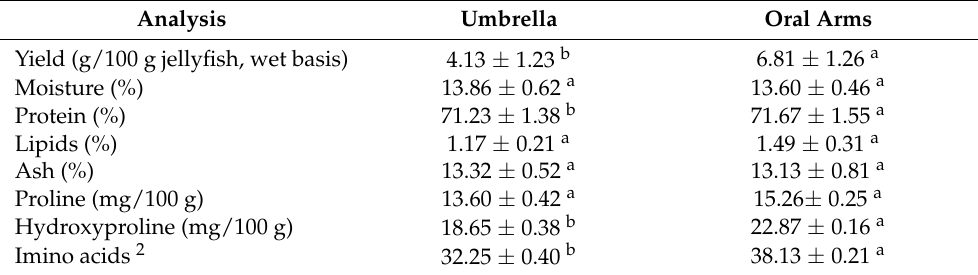
Table 4. Yield and chemical composition of umbrella and oral arm gelatins from dry-salted brown cannonball jellyfish 1